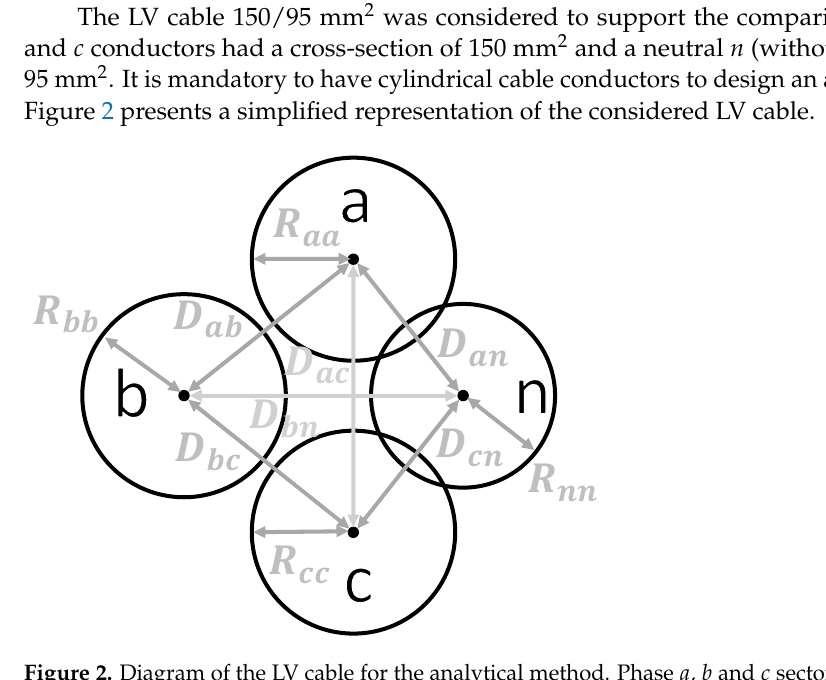
Figure 2. Diagram of the LV cable for the analytical method. Phase a , b and c sectors are transformed into circles of identical surfaces. For the neutral n , the surface of the crown was added to that of the circle. For each phase, the barycenter of the initial shape is used as the center of the circle. Phase sectors were converted into circles with the same cross-section to obtain this simplification. For the neutral, the surface of the crown was added to that of the circle. The distances and radius shown in Figure 2, for cable 150/95 mm 2 , are specified in Equation